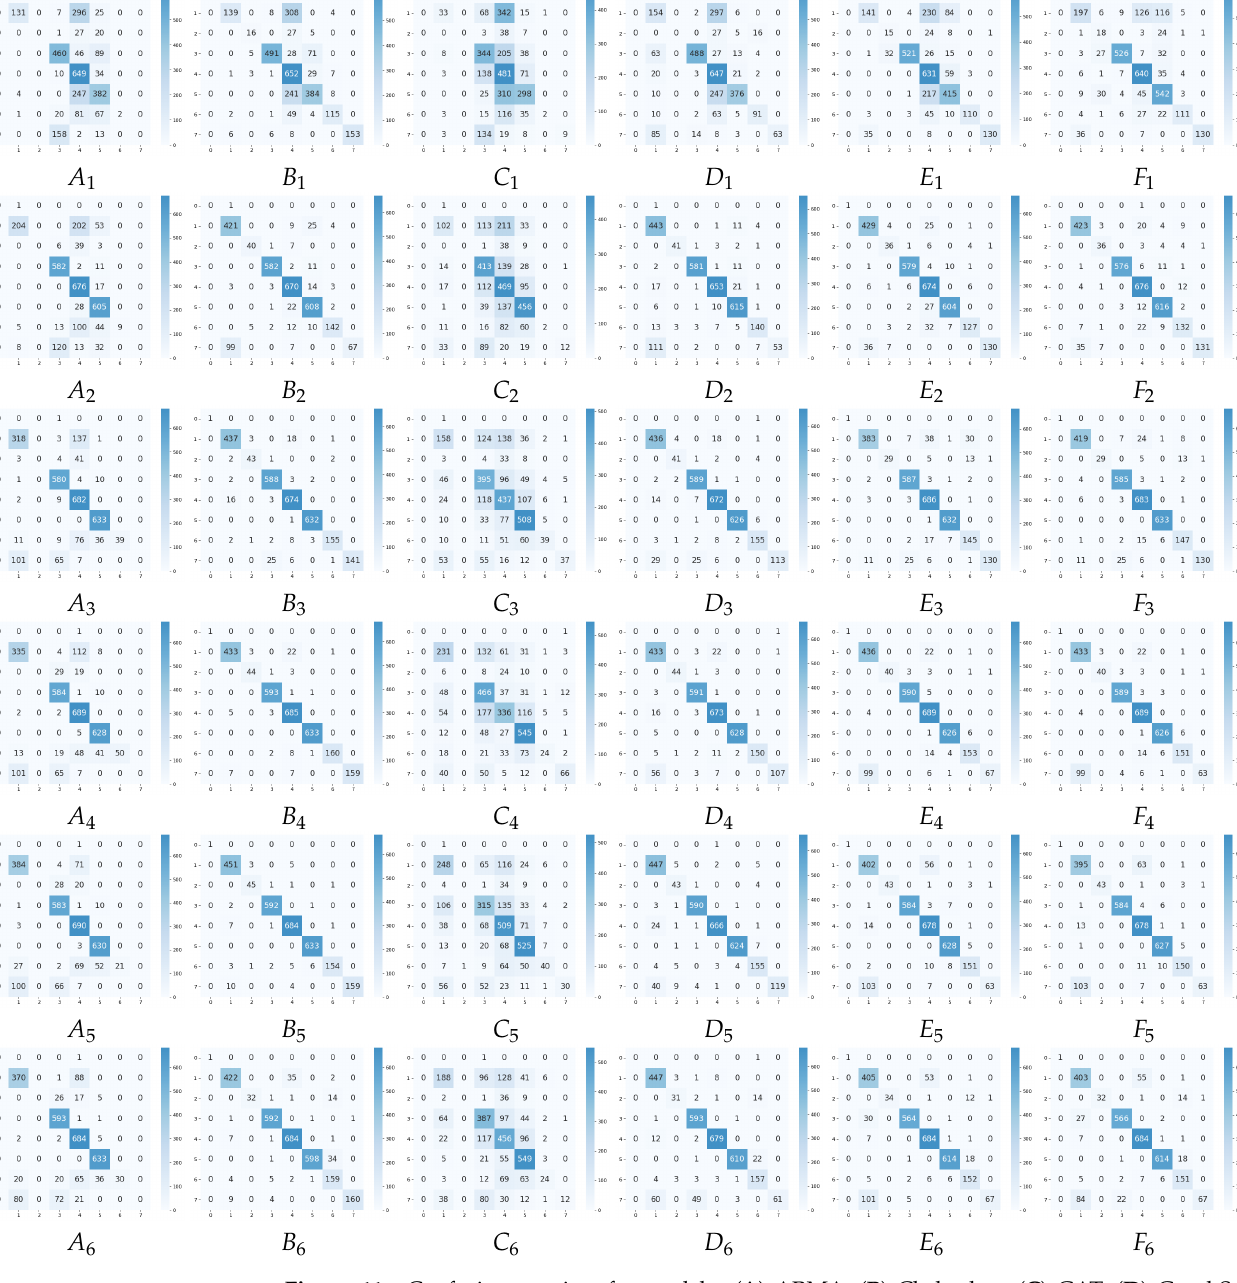
Figure 11. Confusion matrices for models: ( A ) ARMA, ( B ) Chebyshev, ( C ) GAT, ( D ) GraphSage, ( E ) XGBoost, and ( F ) XGBoost with the GIS, which considered 1. 35, 2. 50, 3. 100, 4. 150, 5. 200, and 6. 300